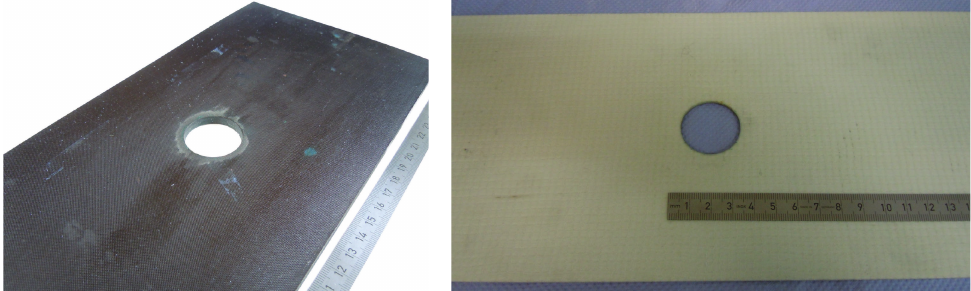
Figure 7: CFRP and multilayer weft knitted fabrics composite plates subjected to CT